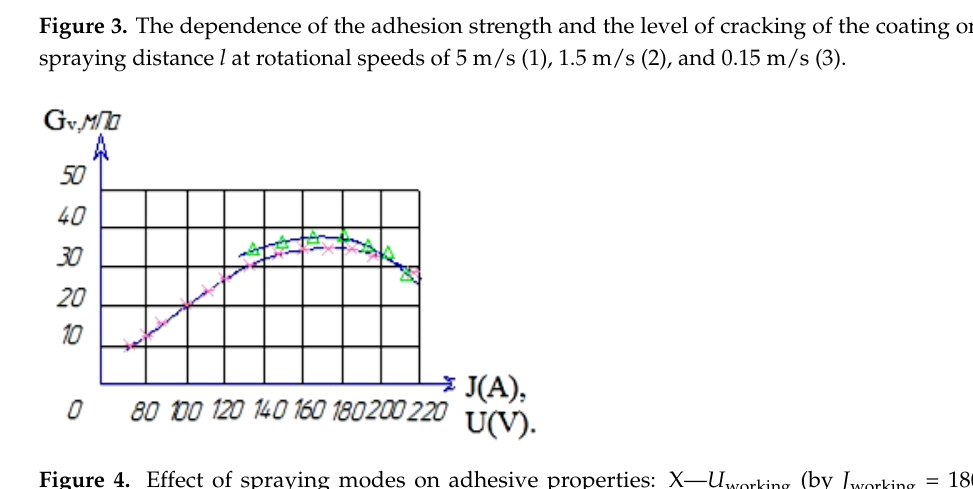
Figure 4. Effect of spraying modes on adhesive properties: X— U working (by J working = 180 A); ∆— J working (by U p = 160 V); Q = air; P = 5 atmospheres; Q = C 3 H 3 0.1 g/s.